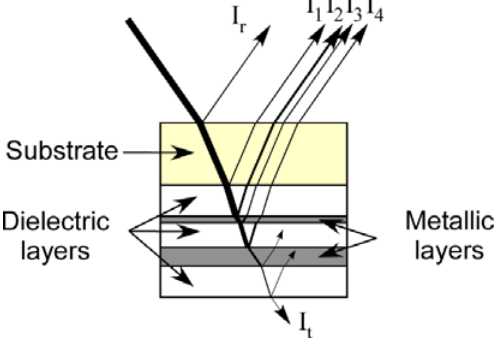
Figure 3. Multilayer structure of decorative coatings.